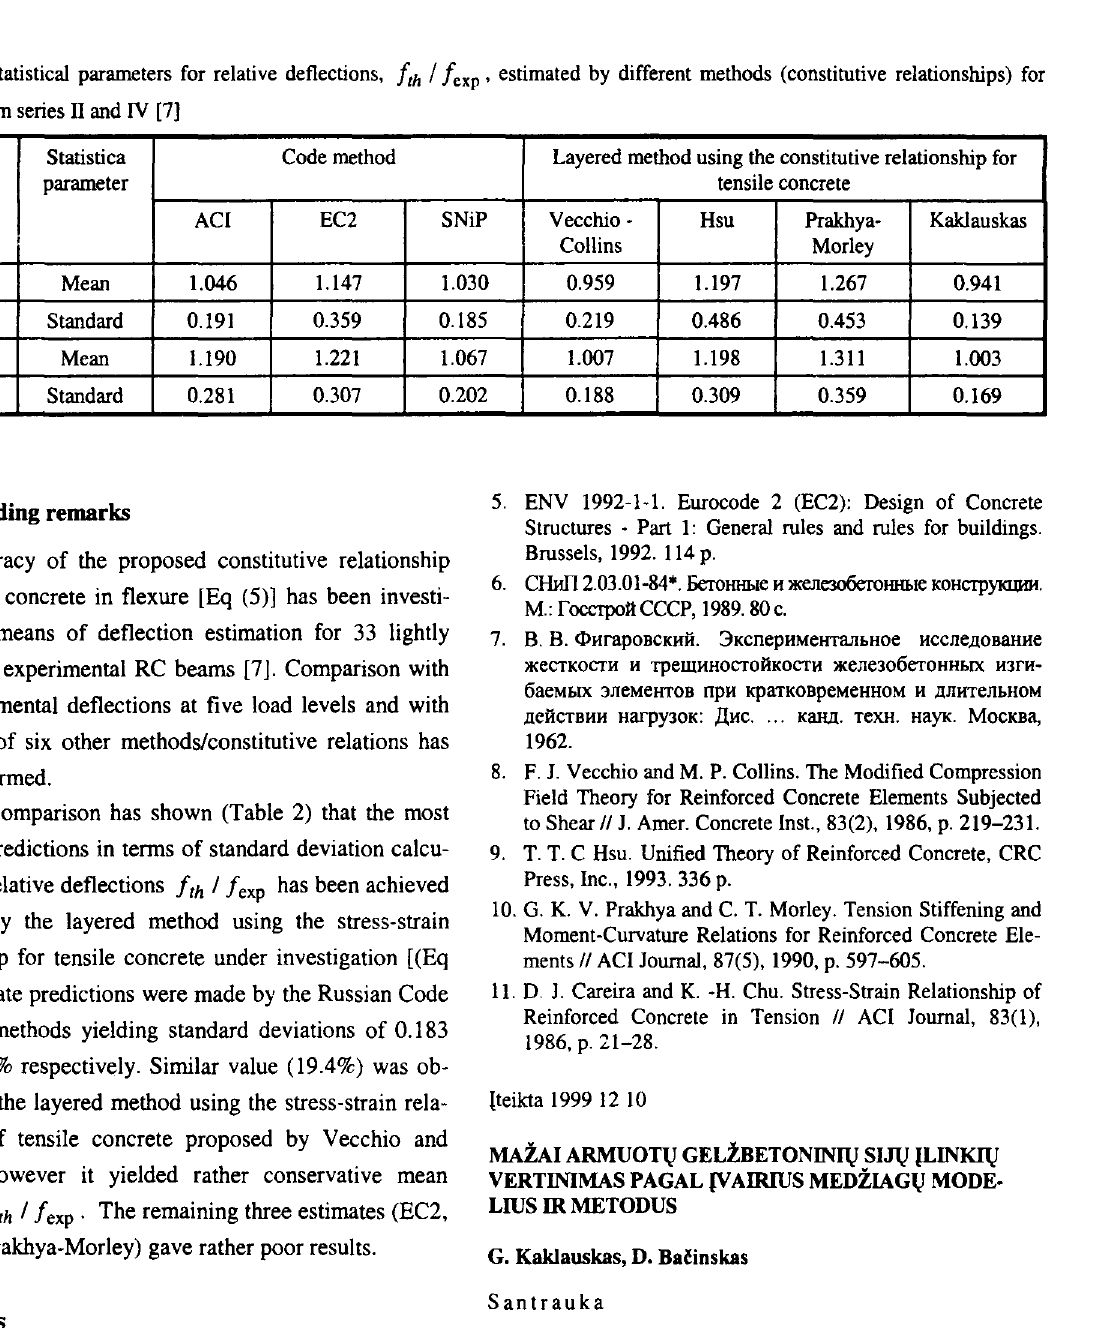
Table 3. Statistical parameters for relative deflections, frh I fexp, estimated by different methods (constitutive relationships) for data of beam series II and IV